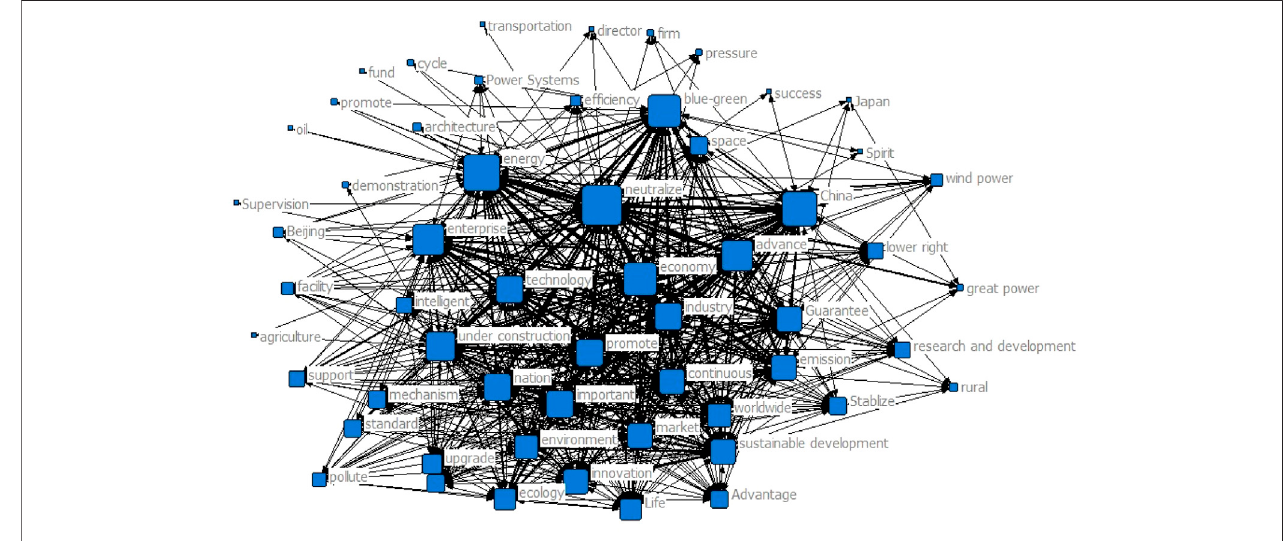
FIGURE 2 | Co-occurrence matrix analysis.